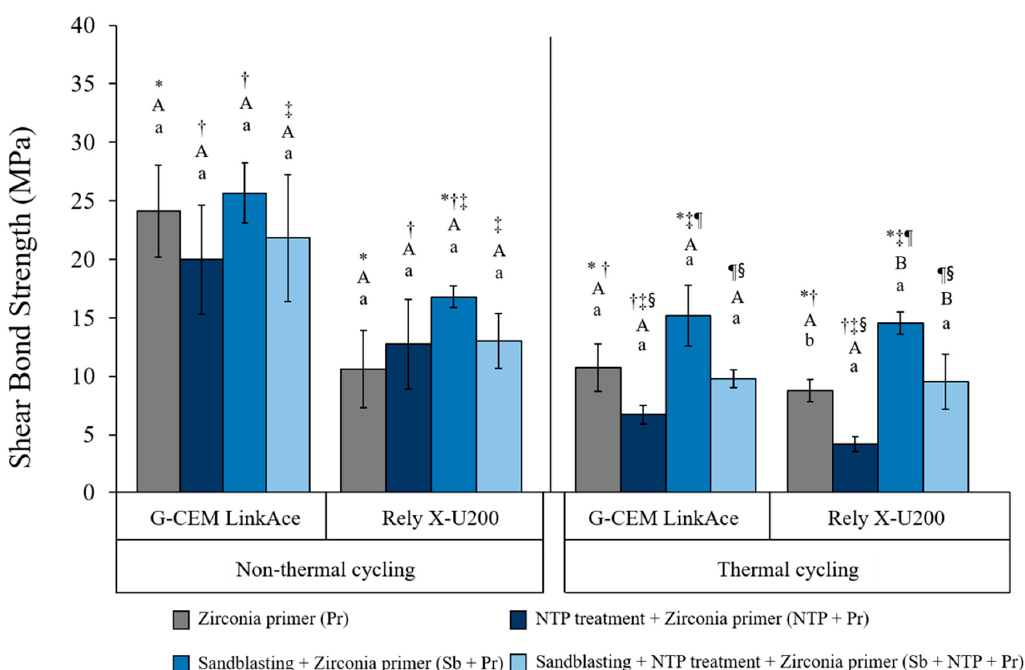
Figure 6. The results of SBS for all experimental groups according to surface treatment methods, effect of thermal cycling and the type of self-adhesive resin cement. The same symbols (*, † , ‡ , ¶, §) indicate a significant difference between surface treatment within the same cement type of the same thermal effect ( p < 0.05). The same upper case letters (A, B) indicate a significant difference between cement types within the same surface treatment of the same thermal effect ( p < 0.05). The same lower case letters (a) indicate a significant difference between thermal effect within the same surface treatment of the same cement types. ( p < 0.05). Pr, Zirconia primer; NTP + Pr, NTP + Zirconia primer; Sb + Pr, Sandblasting + Zirconia primer; Sb + NTP + Pr, Sandblasting + NTP + Zirconia primer.